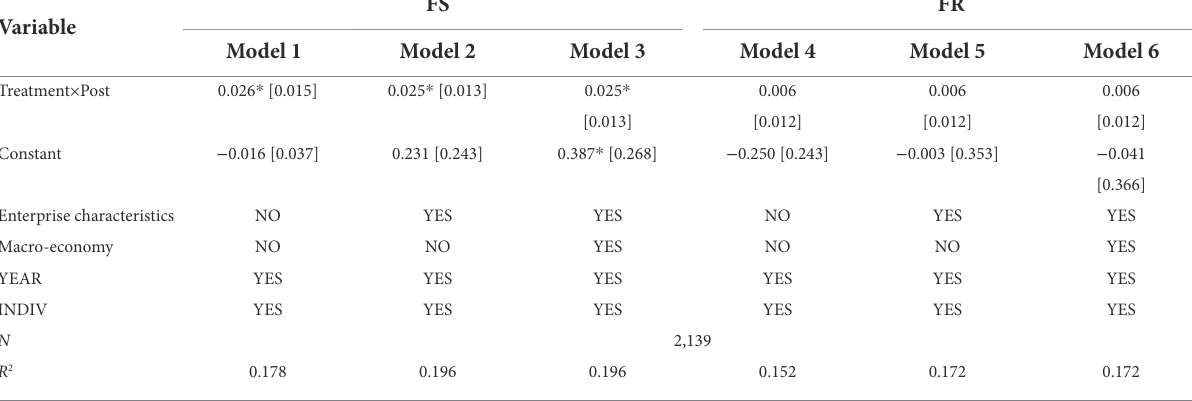
TABLE 7 Analysis with DID method after narrowing the sample size.